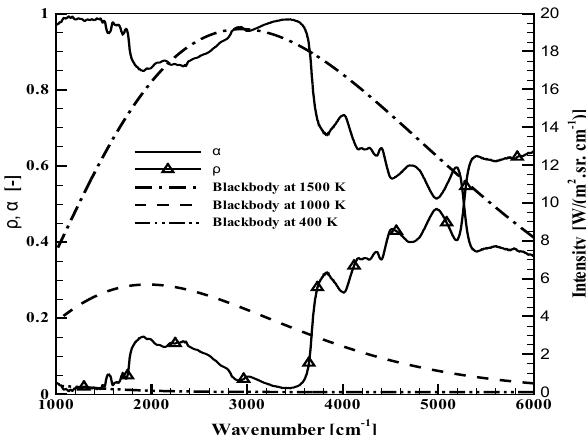
Figure 1. Radiative properties of the virgin plywood sample.